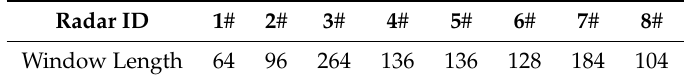
Figure 7. The estimation stocklines of the eight-radar array system measured in the same period. Table 2. Configuration of the FIR filters with the Blackman–Harris windows.